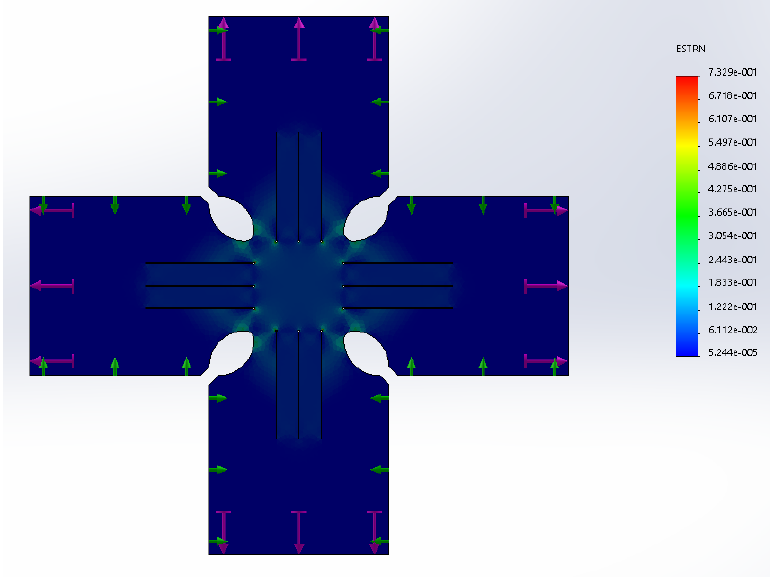
Figure 29. Central region for stress distribution analysis using the von Mises condition of plasticity in the final step of the simulation .